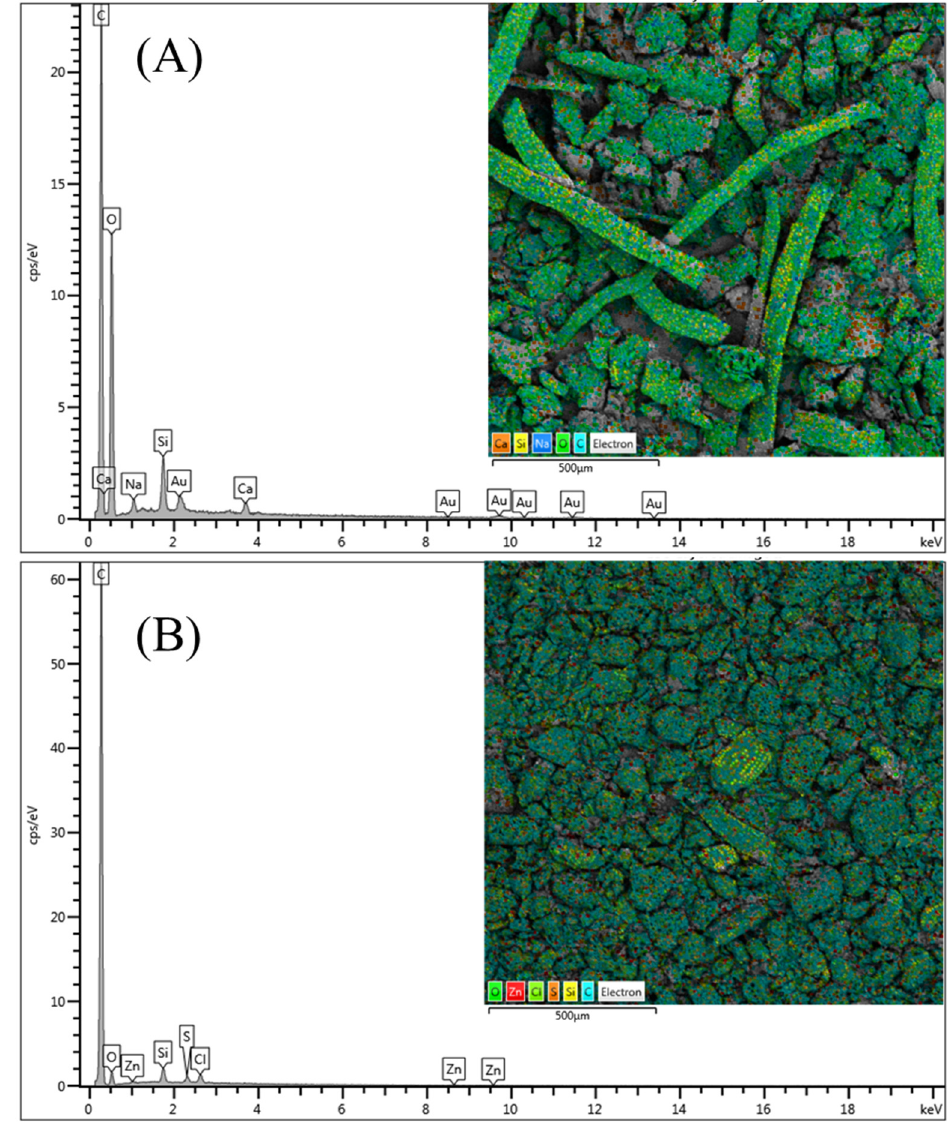
Figure 2. EDS for the precursor ( A ) and AC ( B ).